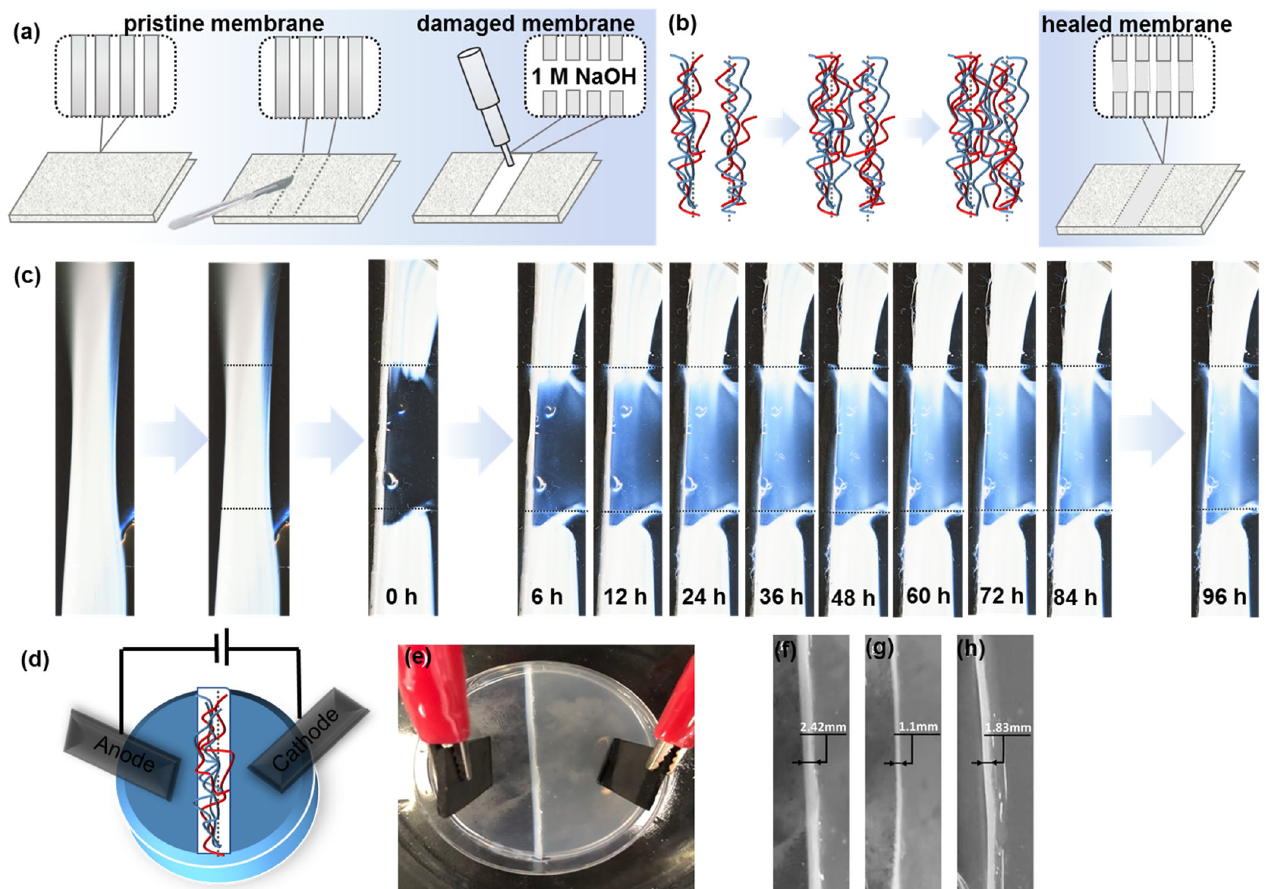
Figure 4. ( a ) Scheme of pristine, damaged, and healed membrane; ( b ) Interdiffusion mechanism of PECs and ( c ) dynamics of its conversion from damaged to self ‐ healed membrane; ( d ) scheme and ( e ) photograph of PEC association ‐ dissociation setup under applied voltage of 5 V and dynamics of self ‐ healing after current cut ‐ off: ( f ) PEC membrane after 24 h of RD self ‐ assembly, w 0 = 2.42 mm ( g ) damaged PEC membrane after 1 h of applied voltage, w 1 = 1.1 mm; and ( h ) self ‐ healed PEC membrane, 24 h after maintenance with applied potential gave the thickness of 1.83 mm.